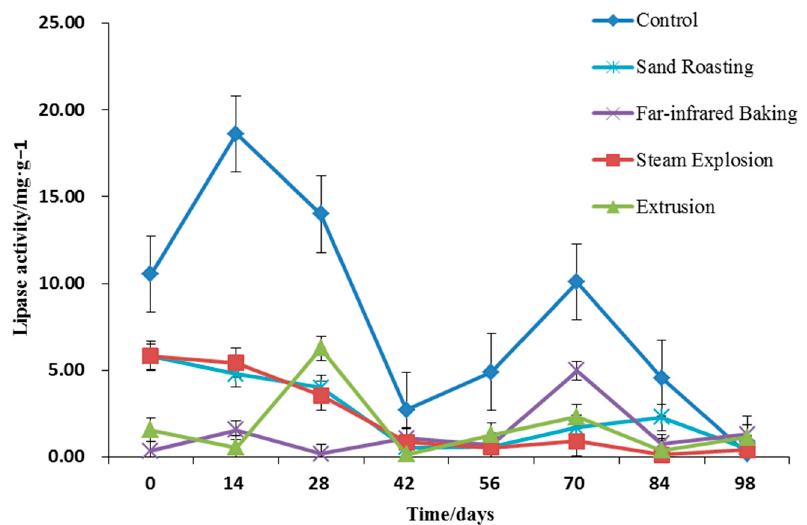
Figure 4. Lipase activity of whole grain highland barley flour with different thermal treatments during storage.